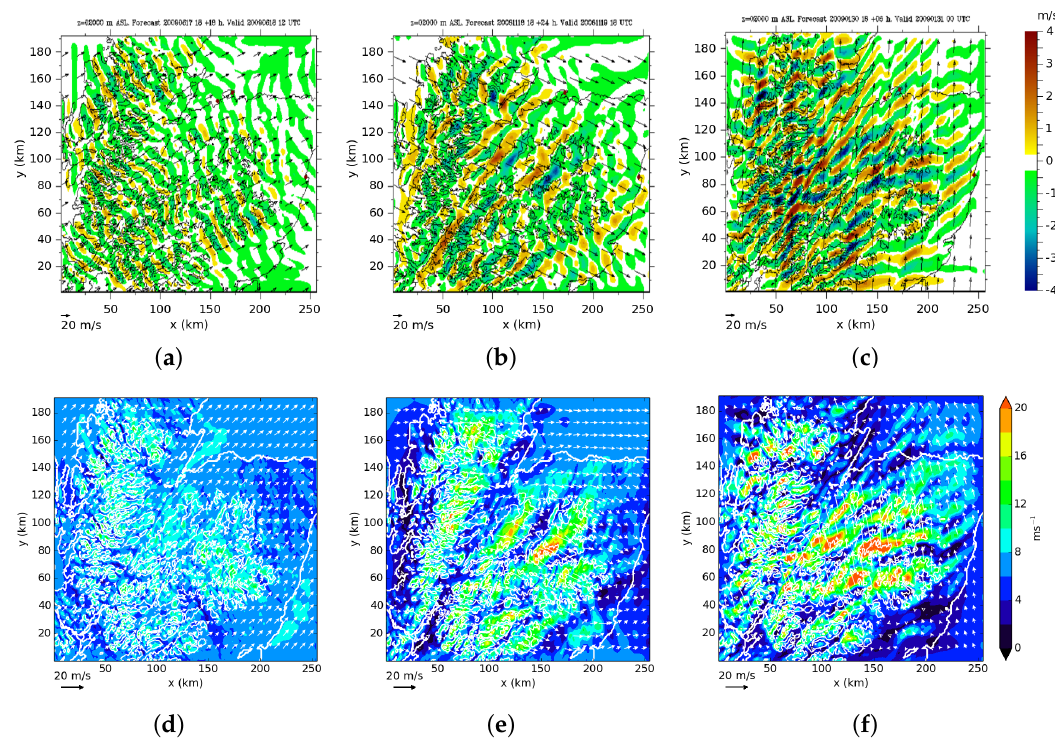
Figure 2. ( a – c ) w at 2000 m ASL and ( d – f ) 10-m winds for the Grampians 3DVOM domain at: (a,d) 12 UTC 18 June 2009 (| u 10 m | = 7.05 ms − 1 , | w 850 hPa | = 0.268 ms − 1 , | ∆ s | = 0.163); (b,e) 18 UTC 19 November 2008 (| u 10 m | = 7.02 ms − 1 , | w 850 hPa | = 0.45 ms − 1 , | ∆ s | = 0.383); (c,f) 00 UTC 31 January 2009 (| u 10 m | = 7.00 ms − 1 , | w 850 hPa | = 0.781 ms − 1 , | ∆ s | =